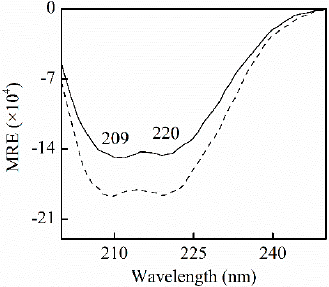
Figure 5. CD spectra for HSA in the absence and presence of SSC in pH7.4, 0.5 M Tris-Cl buffer. C HSA = 0.42 μ M; C SSC = 0.42 μ M. A solid line stands for free HSA. A dotted line is for HSA-SSC. MRE, mean residue ellipticity.